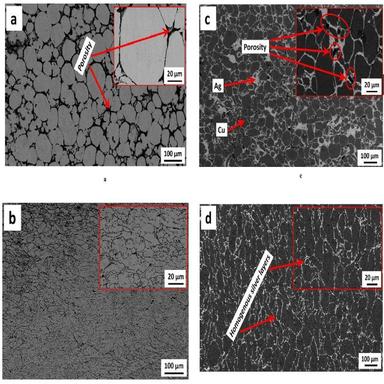
SEM images of microstructures of sb-Cu, fb-Cu, sb-CuAg, fb-CuAg, fb-CuAgNi and fb-CuAgCr bulk materials.